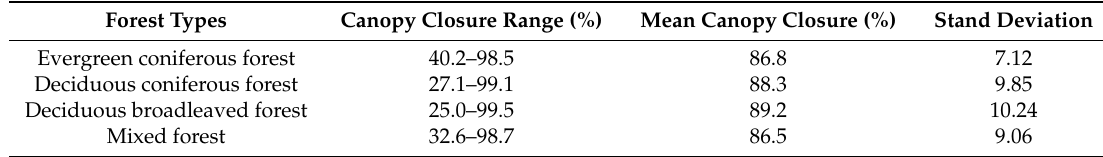
Table 7. Stratified regression models of AGB estimated from GLAS waveform data. Adjusted R 2